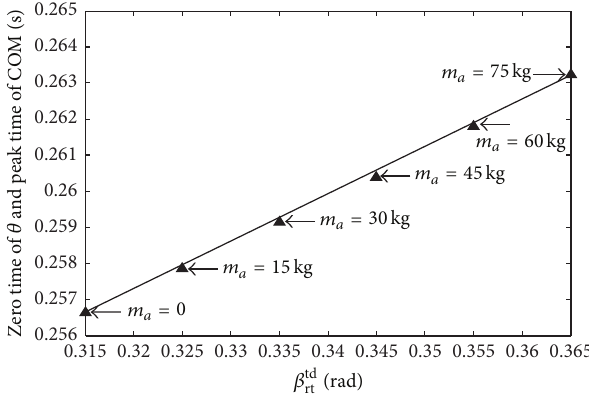
Figure 21: Zero time of pitching angle and peak time of COM. The dark triangles indicate different intersections between the zero time curve of the pitching angle and the peak time curve of COM with different weights of